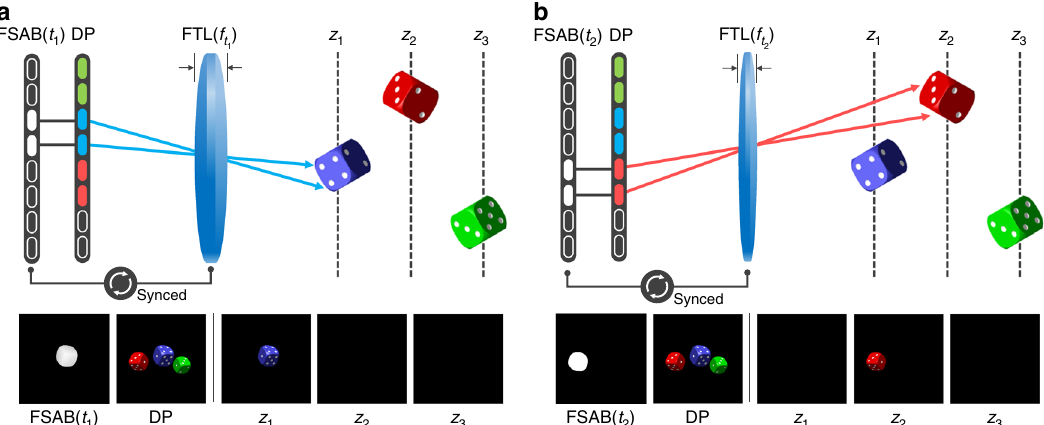
Fig. 1 Schematic diagram of the principle of tomographic displays. As shown in the fi gure, the FSAB and focus-tunable lens (FTL) are synchronized to provide users with depth information. a When the image of the display panel (DP) is formed at the depth of z 1 , the FSAB selectively illuminates the blue dice of the display panel. b When the focus-tunable lens forms the display panel image at the depth of z 2 , the FSAB selectively illuminates the red dice of the display panel. As a result, the blue and red dice appear to fl oat at depths of z 1 and z 2 , respectively. Note that each depth can take on a negative value, which means the image can be created at the left side of the focus-tunable